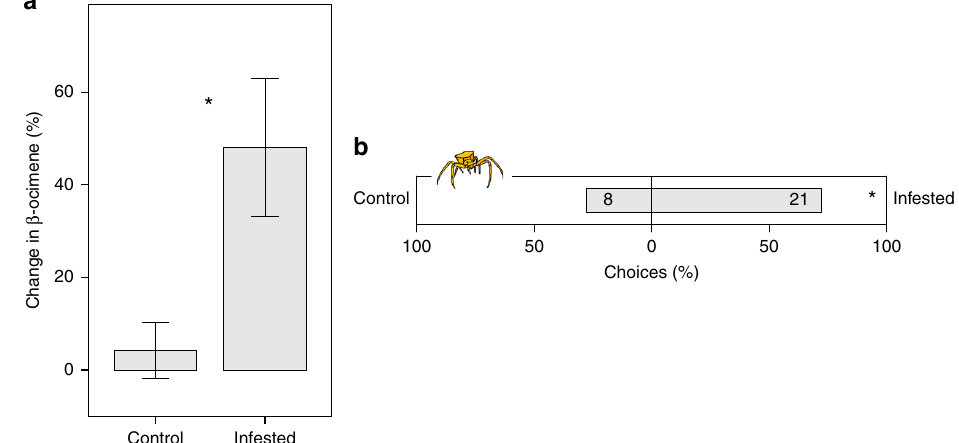
Fig. 4 Tritrophic interaction between Biscutella laevigata , fl orivores and crab spiders. a Inducibility of β -ocimene in fl orivore-infested and control plants ( N = 68). Each bar represents a mean ± s.e., signi fi cant differences between treatments are indicated by an asterisk. b Dual-choice behavioral assays testing the preference of crab spiders for fl orivore infested B. laevigata plants against a control plants. Numbers in bars are the absolute number of choices of in fl orescences. Binomial test: ns: P > 0.05, * P < 0.05, ** P < 0.01, *** P < attracted bees (estimate ± s.e. = 0.12 ± 0.04, z = 2.87, P = 0.004), but when crab spiders were present, no association between bee visitation and β -ocimene could be detected (estimate ± s.e. = − 0.06 ± 0.04, z = − 1.59, P = 0.11). Additionally, the time an signi fi cant negative effect on the number of bee visits (estimate ± s.e. = − 0.03 ± 0.01, z = − 3.015, P = 0.003).